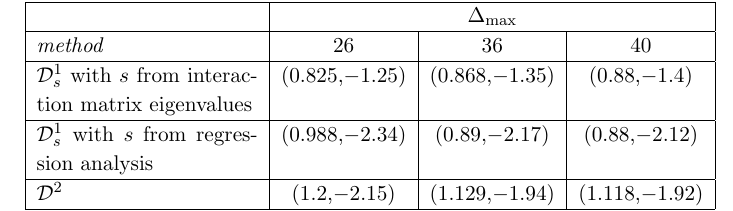
Table 2. Best (cid:12)ts for the leading IR exponent t , for the (cid:12)xed